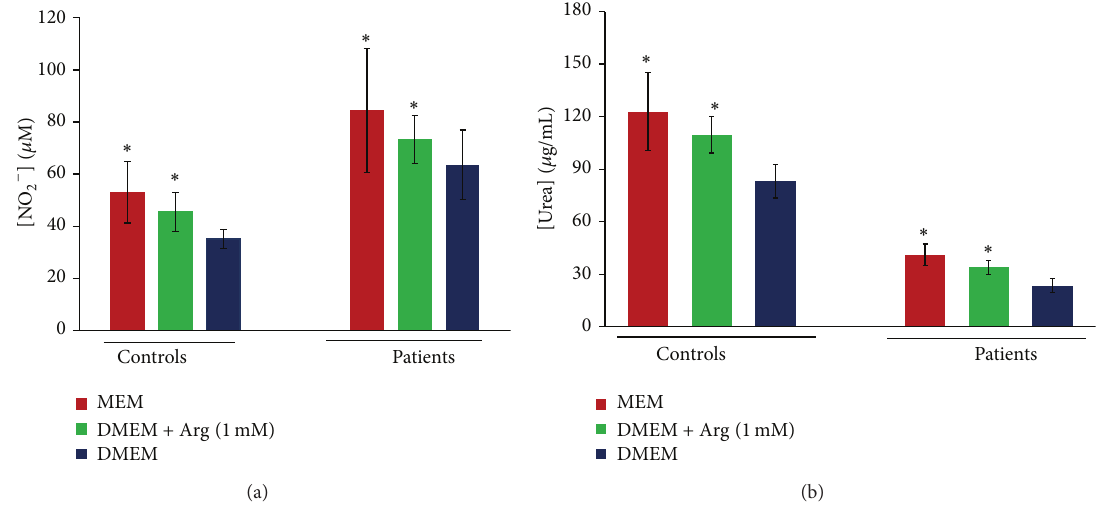
Figure 6: Effect of L-arginine and culture medium on NO (a) and urea (b) production by patients’ ( 𝑛 = 23 ) and controls’ ( 𝑛 = 10 ) PBMC cultures (controls: control subjects, ∗ : significantly different from DMEM with 𝑃 < 0.05